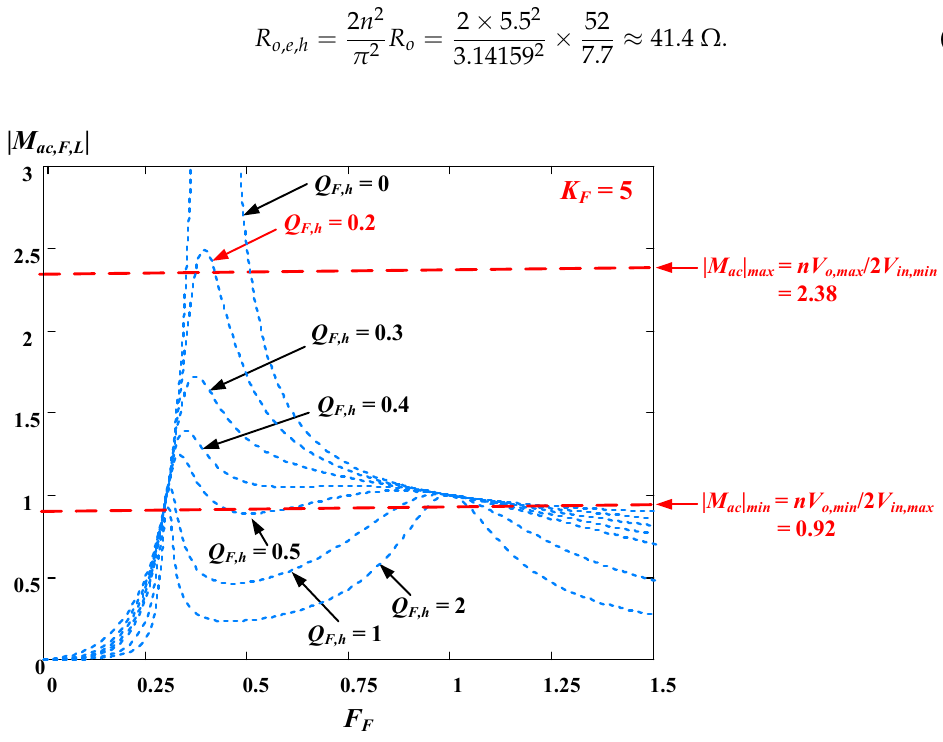
Figure 6. Gain curves of the converter at low voltage range input. The resonant components on the primary-side of the converter are calculated in Equations (16) and (17).